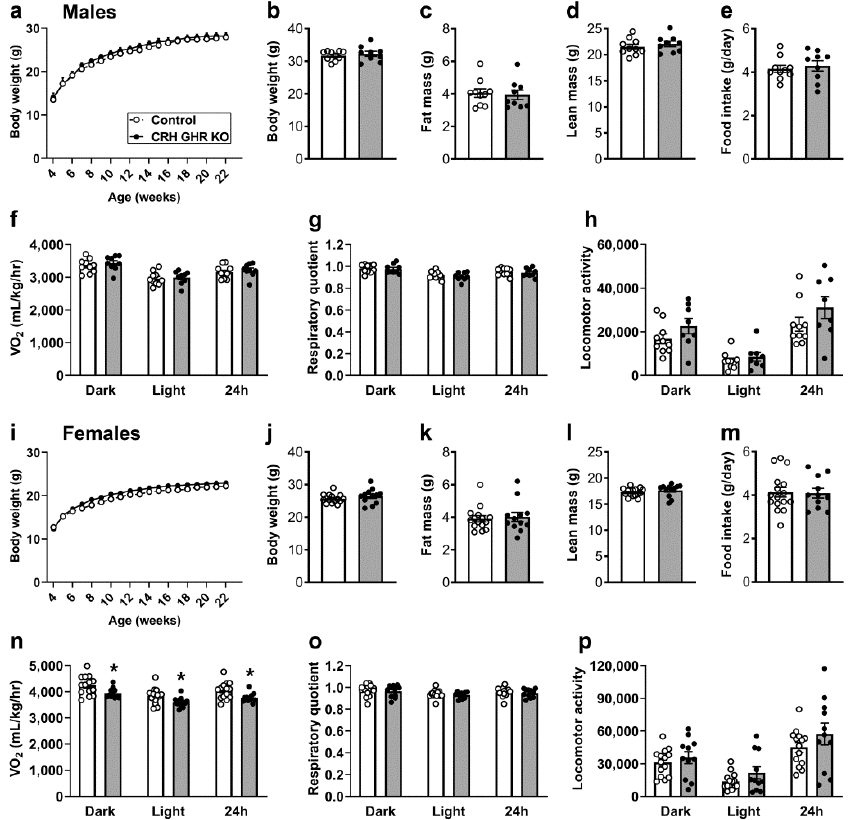
Figure 2. Reduced energy expenditure in CRH GHR KO female mice. ( a ) Changes in body weight along time in control ( n = 10) and CRH GHR KO ( n = 9) male mice. ( b ) Body weight. ( c ) Body fat mass. ( d ) Lean body mass. ( e ) Daily food intake. ( f ) Oxygen consumption (VO 2 ). ( g ) Respiratory quotient. ( h ) Ambulatory activity. ( i ) Changes in body weight along time in control ( n = 15–16) and CRH GHR KO ( n = 11–12) female mice. ( j ) Body weight. ( k ) Body fat mass. ( l ) Lean body mass. ( m ) Daily food intake. ( n ) VO 2 . ( o ) Respiratory quotient. ( p ) Ambulatory activity. * p < 0.05.